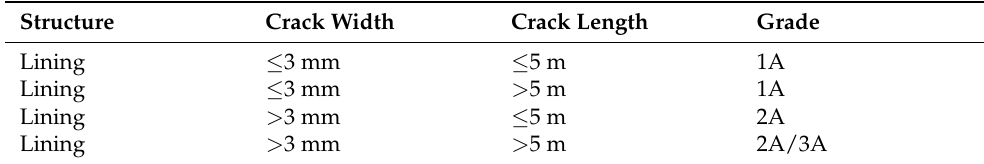
Table 4. Grading of cracks according to the Chinese standards from